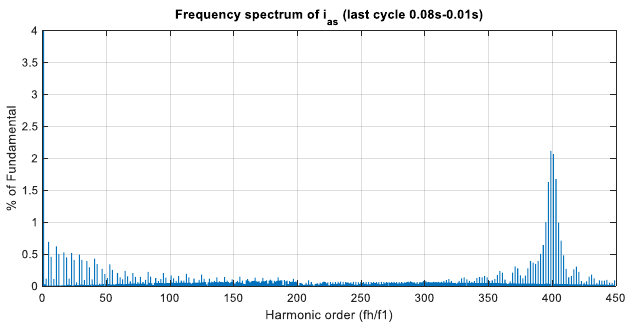
Figure 14. Supply currents before and during SAPF compensation.